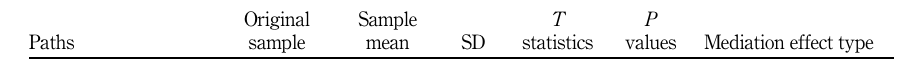
Table 6. Total standardized indirect effects of transformational leadership on international